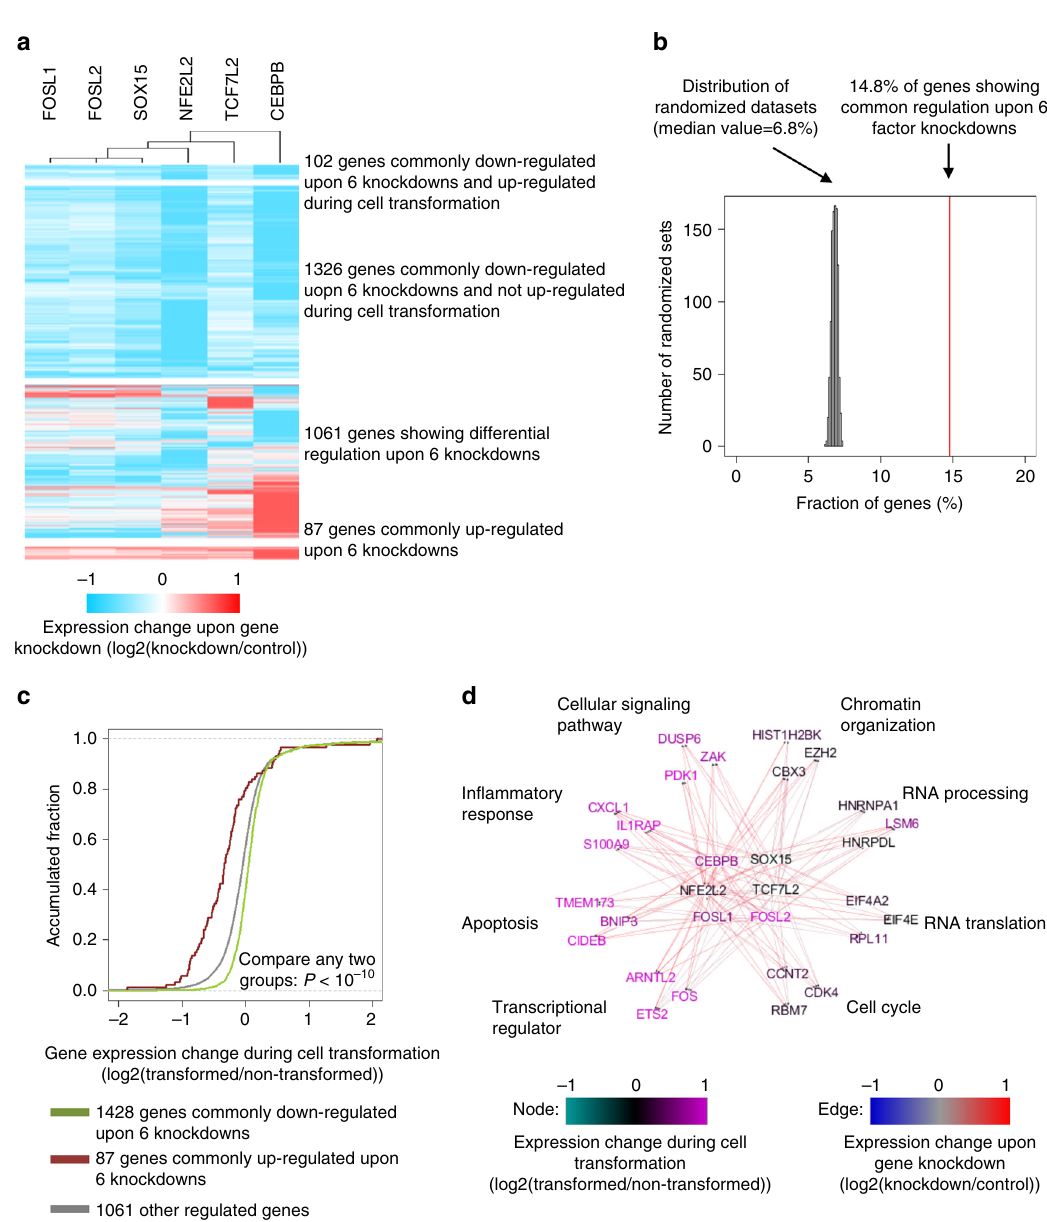
Fig. 6 Gene expression network mediated by transcriptional regulators. a Genes showing signi fi cant differential gene expression upon factor knockdowns, with 2-fold differential expression in at least one knockdown. b Fraction of expressed genes showing consistent up- or down-regulation upon 6 factor knockdowns compared to those obtained by randomizing each column of the datasets. c Dynamic regulation of gene expression of gene groups in a during transformation. The cumulative distribution function fold changes values (log2(transformed/non-transformed)) is plotted. d The gene transcription network mediated by the transcription factors. The edges represent direct factor binding sites in promoters/enhancers of targeted genes. For each pathway, 3 randomly picked genes are